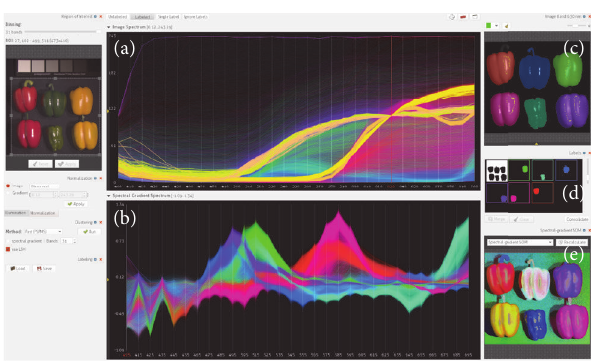
Figure 1: Gerbil user interface. (a) Spectral distribution view, (b) spectral gradient distribution view, (c) spatial view of a single image band with segment overlays, (d) label manager, and (e) false-color